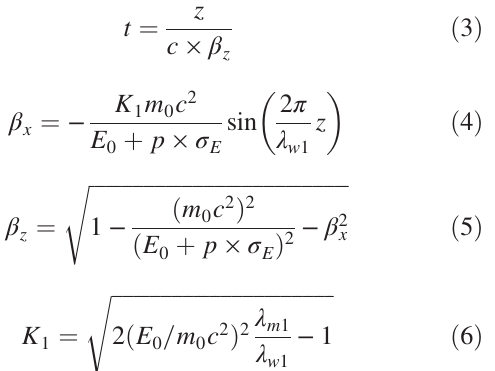
ffiffiffiffiffiffiffiffiffiffiffiffiffiffi λ z = π i ri